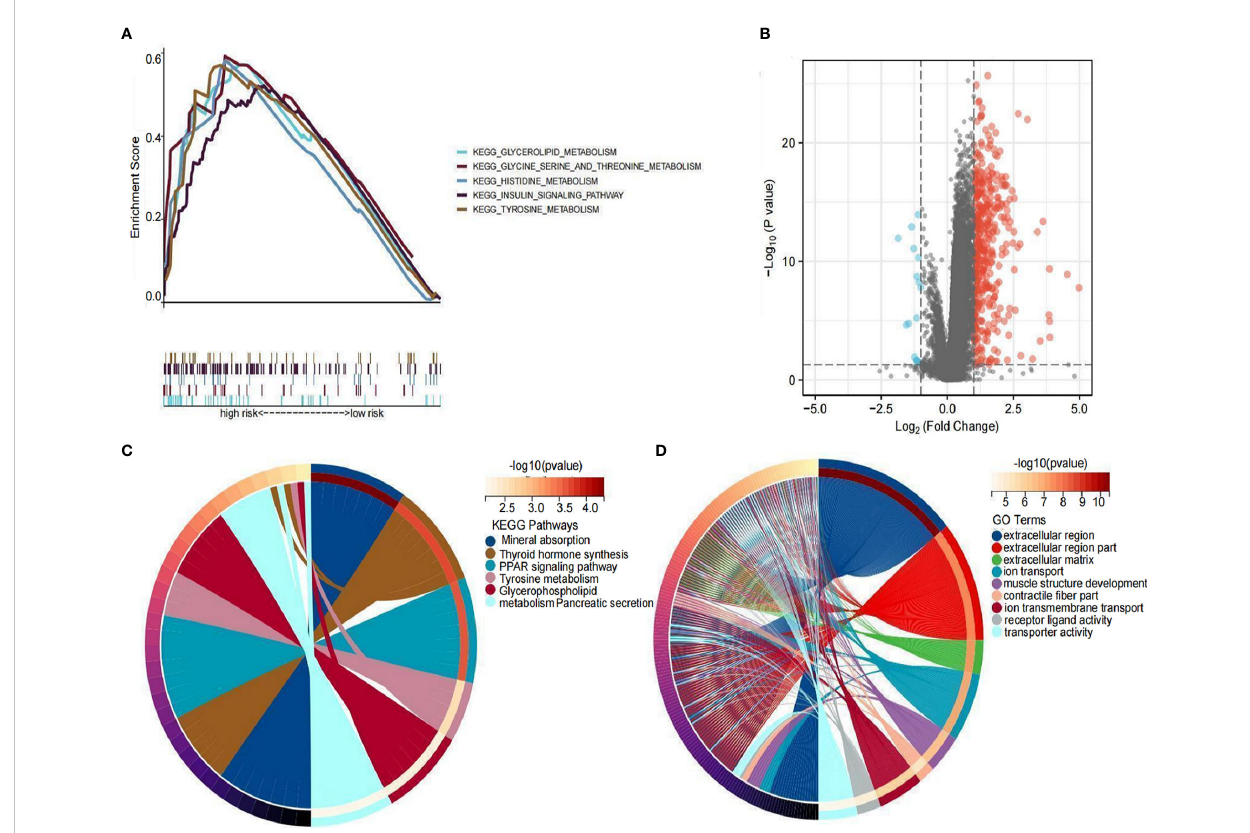
FIGURE 11 Functional enrichment analysis. (A) GSEA on the high-risk group. (B) Distribution of differential LRLs between the high- and low-risk groups: log 2 FC >1 for the red bubble and log 2 FC<-1 for the blue bubble. (C) KEGG enrichment analysis of the differentially expressed genes between the high- and low-risk groups. (D) GO enrichment analysis of the differentially expressed genes between the high- and low-risk groups.